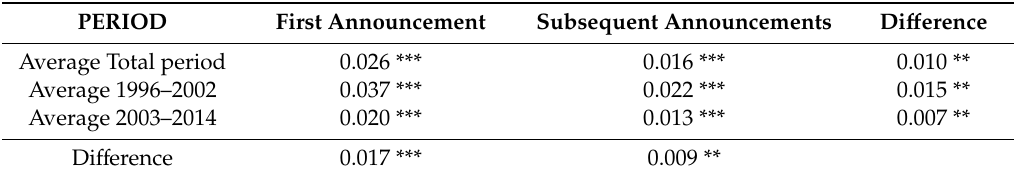
Table 2. First and subsequent market-adjusted announcement